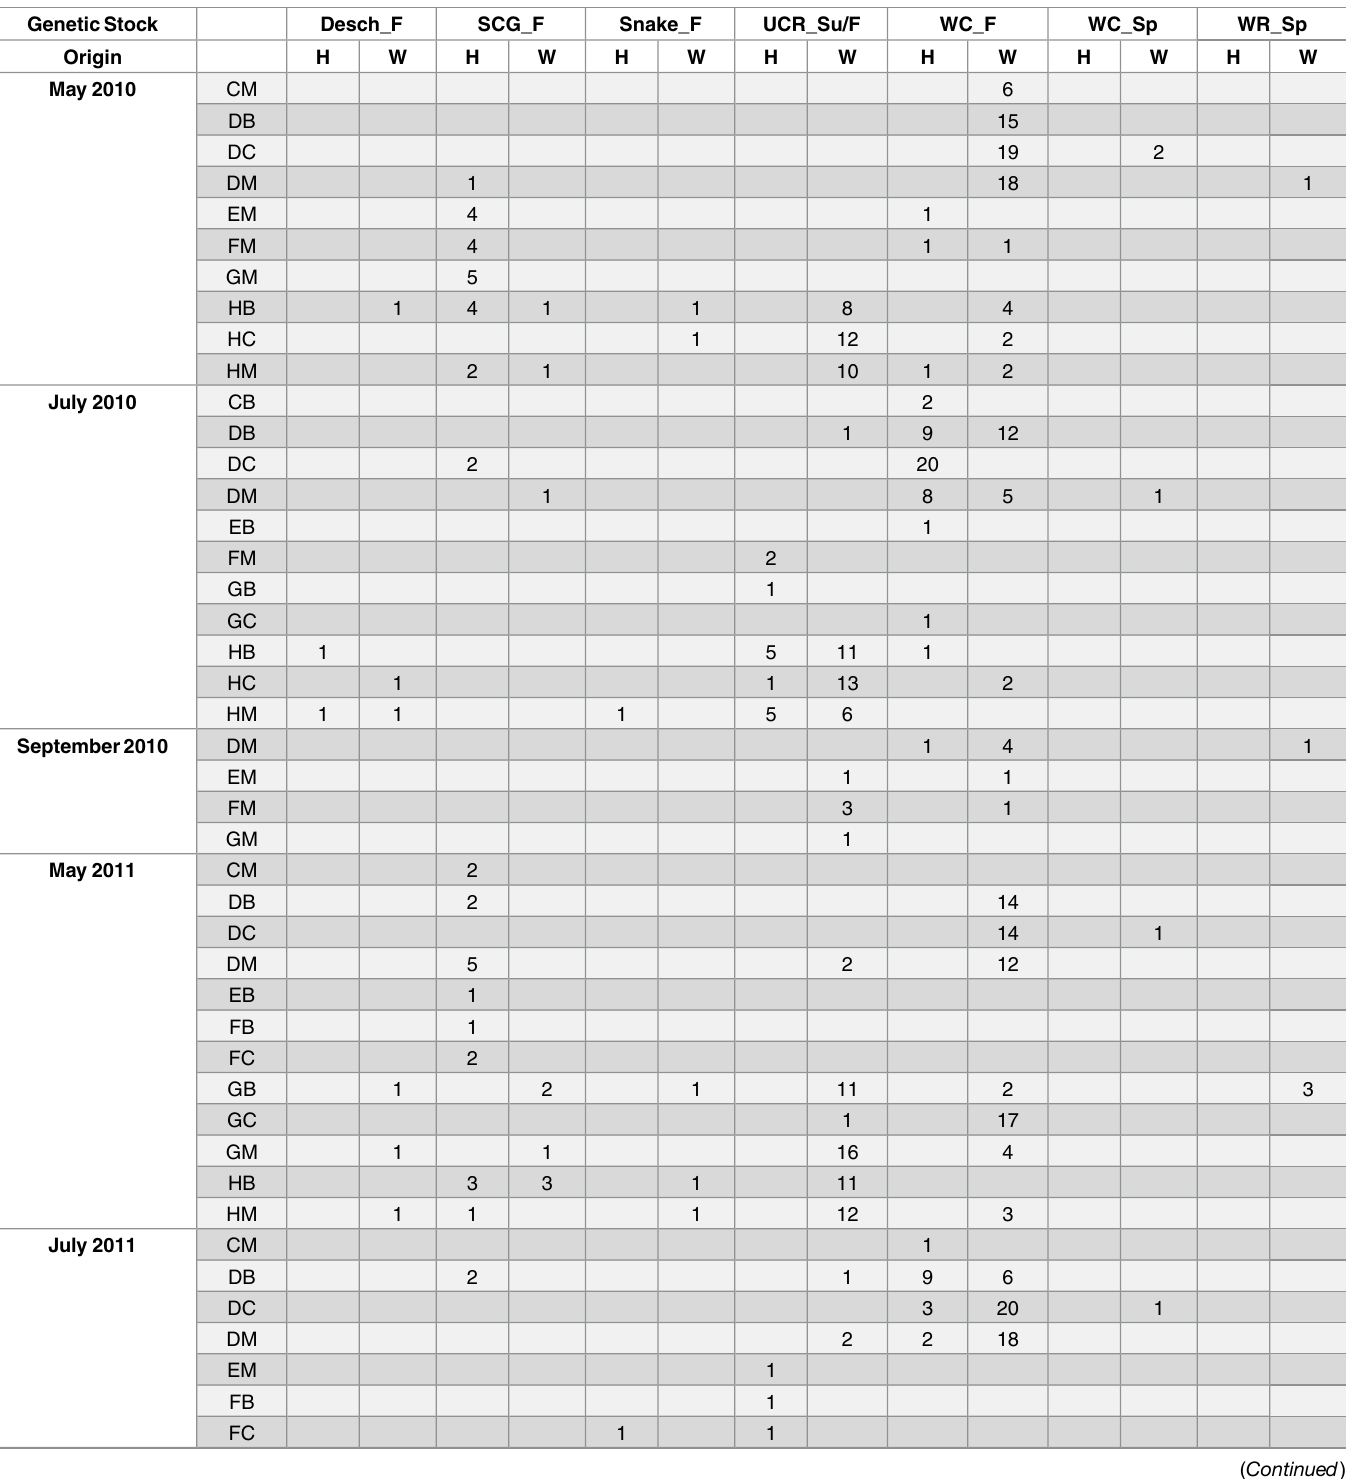
Table 3. Summaryof the number of fishsampledby month,year, site,geneticstock of originand hatchery(H) or wild (W)origin. Each site was coded by the sampling design,with the first letterrepresenting the reach and the second letterrepresenting the habitattype (e.g., the mainstemchannel of reach C was